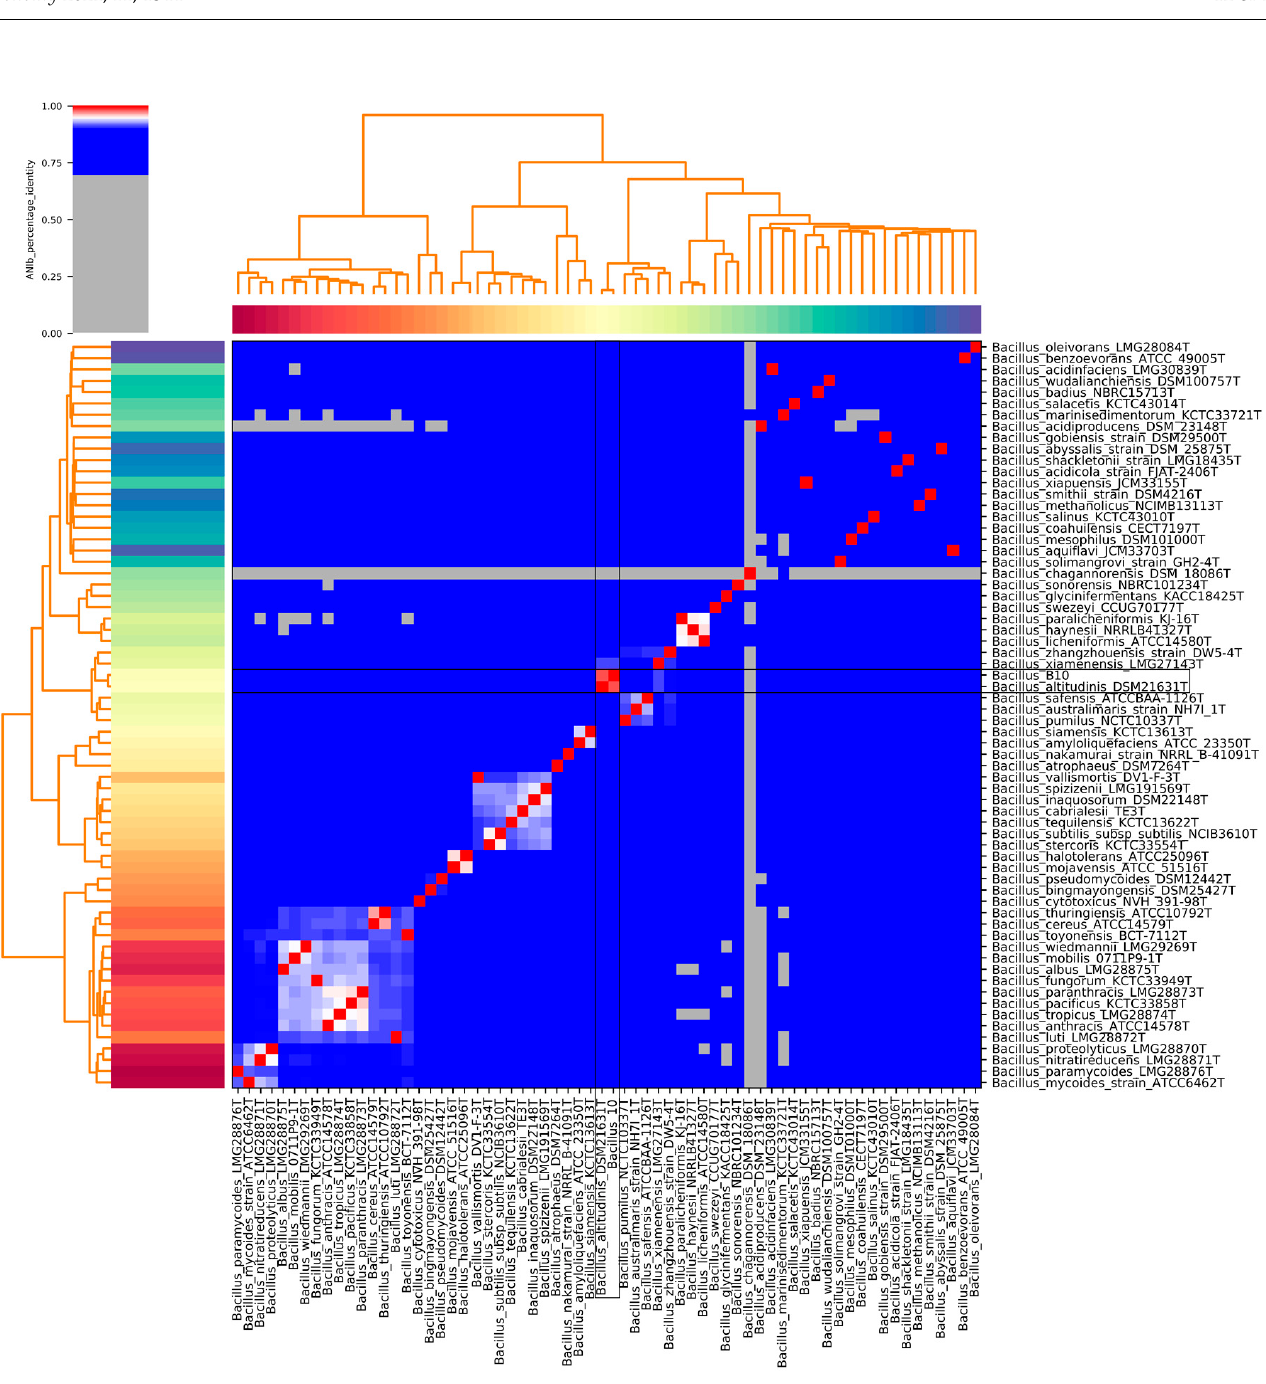
Figure 7. Average Nucleotide Identity (ANI) based on BLAST among Bacillus sp. B10 and type strains of the genus Bacillus . The ANI was calculated using the Pyani program after BLASTn alignment. The ANI above 97% between two genomes is an indication that they belong to the same